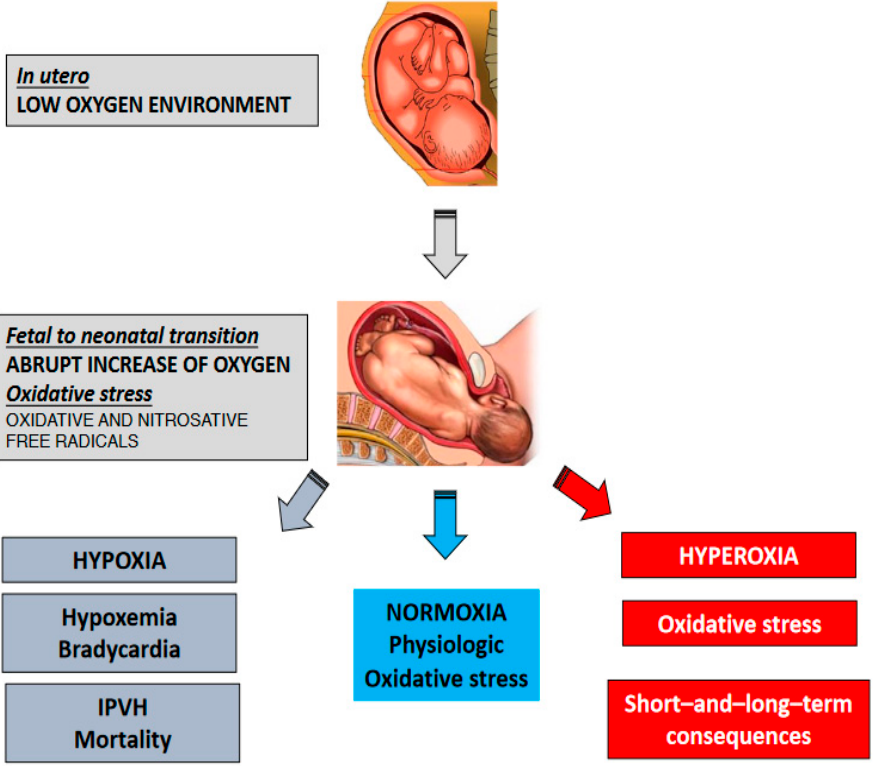
Figure 2. Fetal-to-neonatal transition implies a drastic change to the oxygen provided to the tissue causing physiologic oxidative stress. However, under pathological circumstances, an excess of oxy- gen can lead to hyperoxia and subsequent pathologic oxidative stress and tissue damage with long and/or short-term consequences. In contrast, low oxygenation can cause hypoxemia, bradycardia, and consequently serious complications such as intra-peri-ventricular hemorrhage (IPVH) and/or